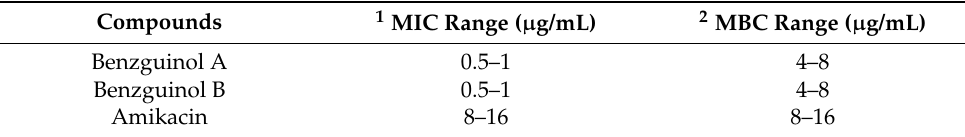
Table 1. In vitro activities of benzguinols A and B against methicillin-resistant Staphylococcus pseudin- termedius